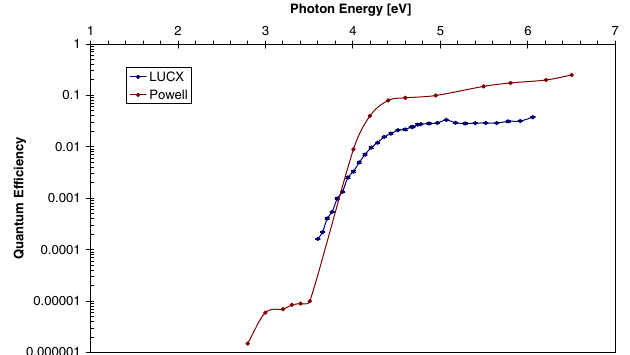
FIG. 8. Measured dependence of quantum efficiency on inci- dent photon energy. The blue curve corresponds to the LUCX data. The brown points correspond to the data from Powell from Ref.